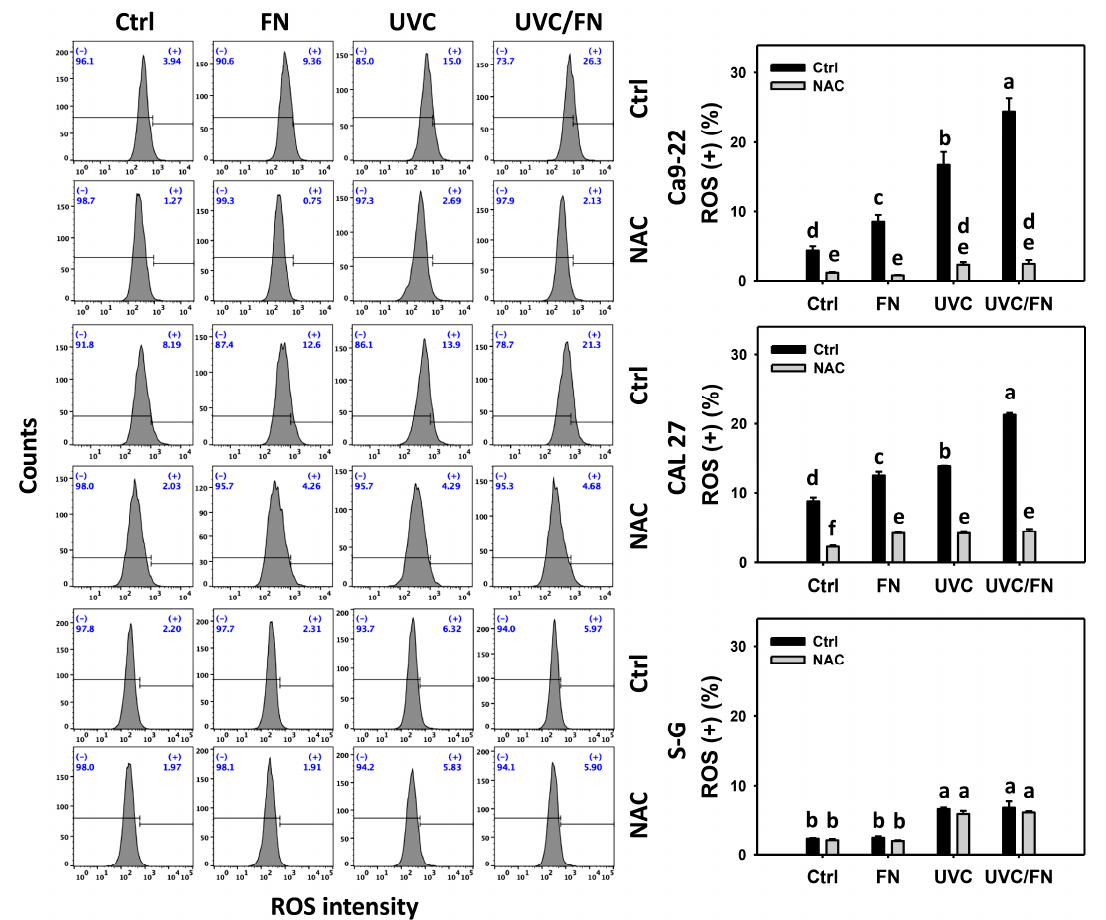
Figure 6. ROS determination. There are four kinds of treatments for oral cancer and non-malignant oral (S–G) cells: control, FN (300 µ g/mL), UVC (10 J/m 2 for Ca9-22; 15 J/m 2 for CAL 27 and S–G), and UVC/FN (10 J/m 2 /300 µ g/mL for Ca9-22; 15 J/m 2 /300 µ g/mL for CAL 27 and S–G). NAC indicates that cells were pretreated with 10 mM NAC. Their intensity changes were evaluated by flow cytometry after 24 h treatment. ROS (+) populations are indicated with (+). Data are provided as means ± SD ( n = 3). Significant differences are indicated by non-overlapping, lower-case letters ( p < 0.05).